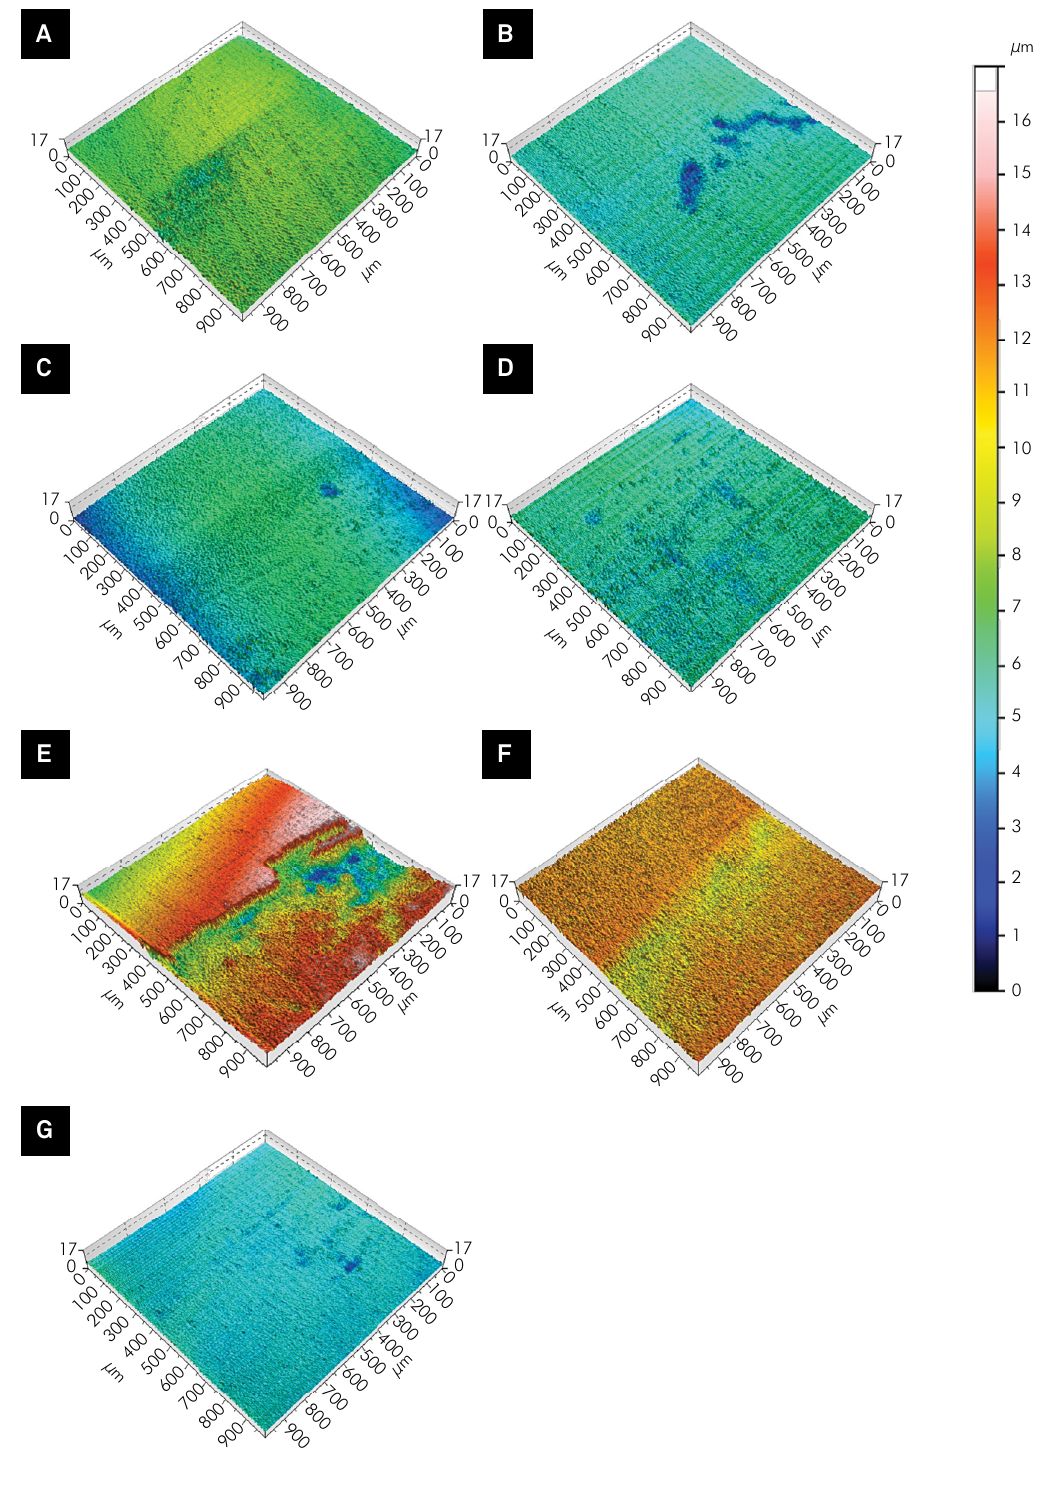
Figure 1. 3D profilometry scheme representation of enamel surfaces after treatment and pH cycling. left – sound window (unexposed area) and right – experimental window (exposed area). (A) G1: Alivium ® , (B) G2: Novalgina ® , (C) G3: Betamox ® , (D) G4: Clavulin ® , (E) G5: Claritin ® , (F) G6: Polaramine ® , and (G) G7: Milli-Q water (negative